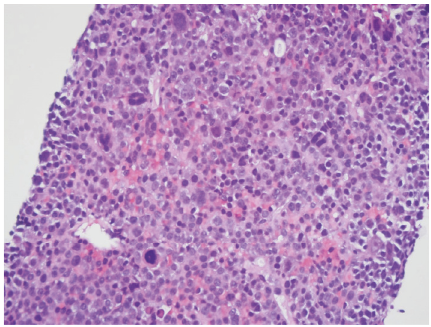
Figure 4: Liver biopsy H&E stain demonstrating compact sheets of atypical plasma cells, consistent with extramedullary hepatic